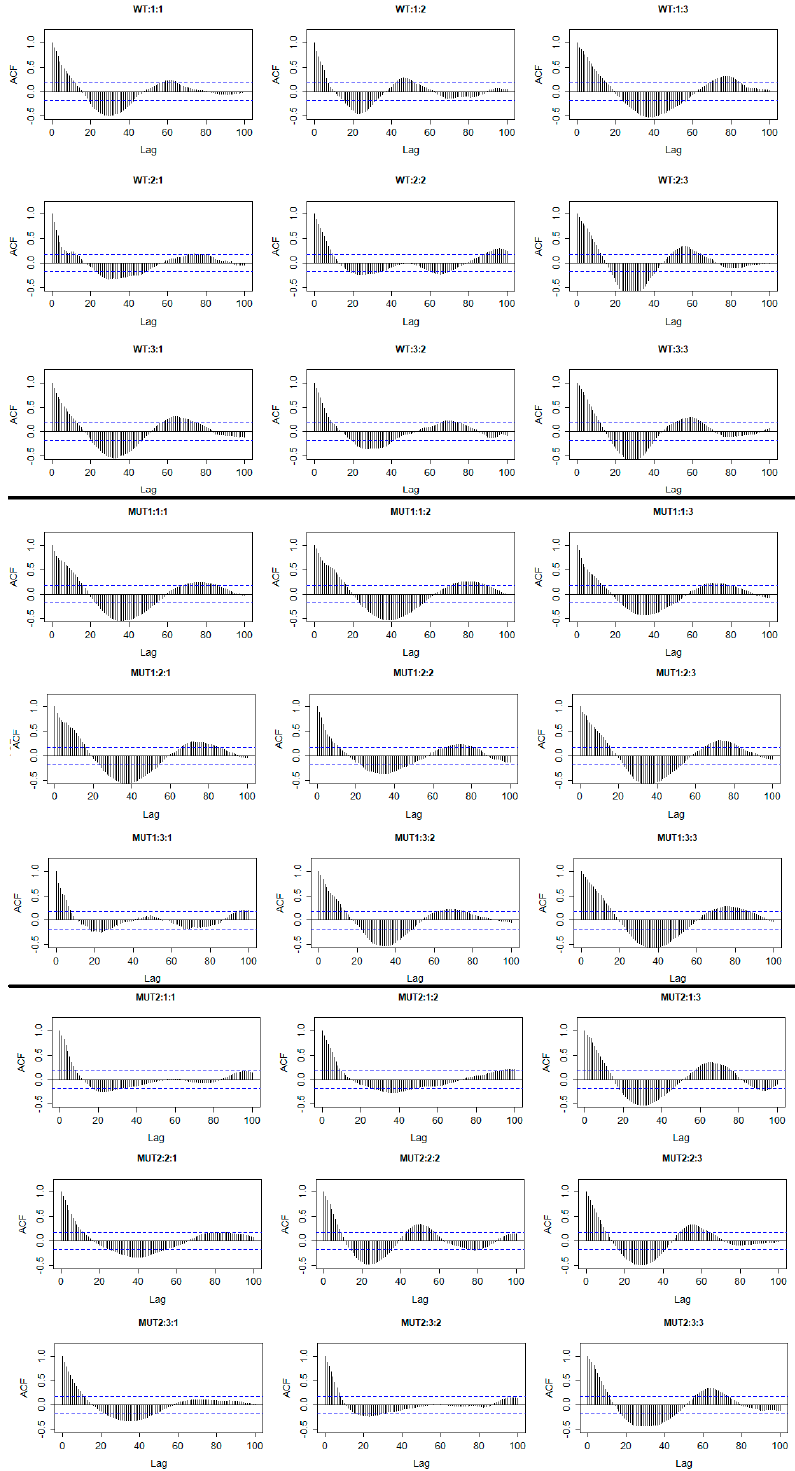
Figure 2. Estimated autocorrelations of the residuals of the initial model given by Equation (3). The title of each plot refers to Genotype: Replicate: Experiment (WT: Wild Type, MUT1: Mutant 1, MUT2: Mutant 2). The dashed blue lines represent the 95% confidence interval. More information about the au- tocorrelation function is given in Appendix A. It can be observed in the residuals of every time series that